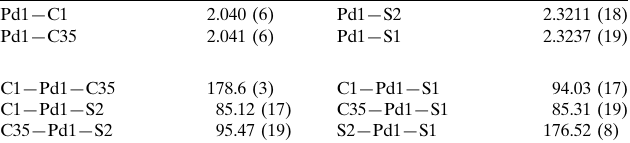
Selected geometric parameters (A˚ , (cid:1)